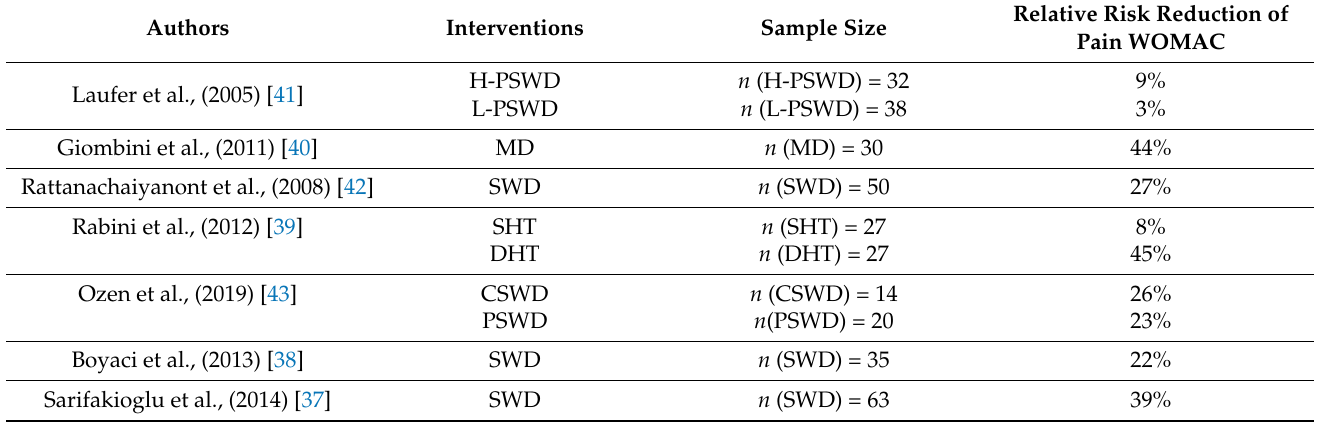
Table 1. Summary of the findings from the seven papers with interventions regarding diathermy, sample size, and the relative risk reduction for WOMAC pain subscale. H-PSWD (high-pulse